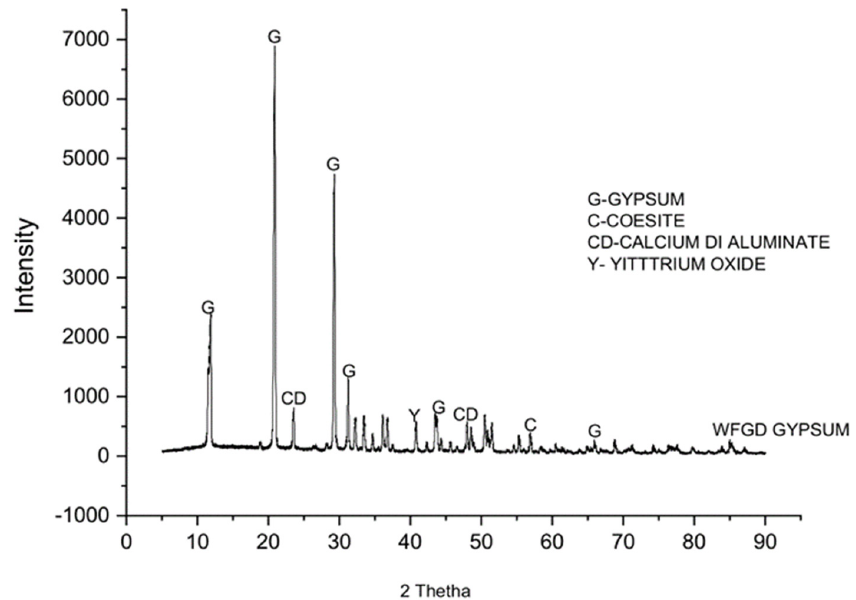
Figure 1. X-ray pattern of WFGD gypsum.